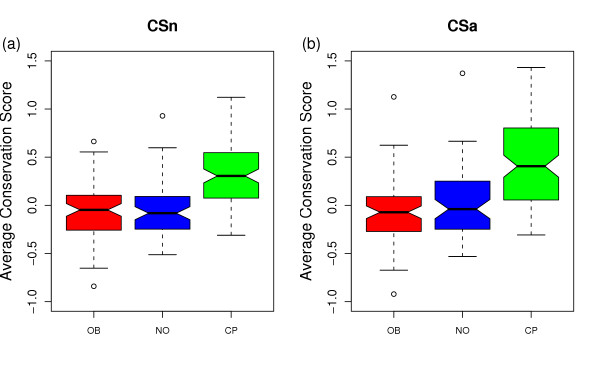
Boxplot of conservation scores of the interfaces for the   BNCP-CS dataset, calculated using number-based strategy (a),   and area-based strategy (b).  Lower conservation scores indicate higher degree of conservation.